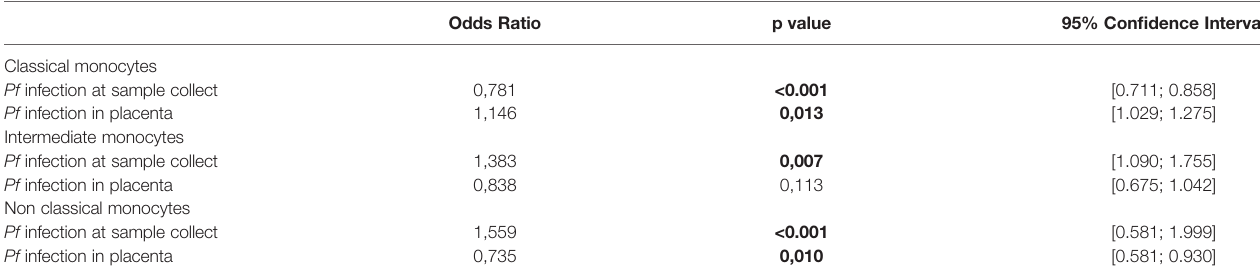
TABLE 2 | Placental malaria decreases non-classical monocyte